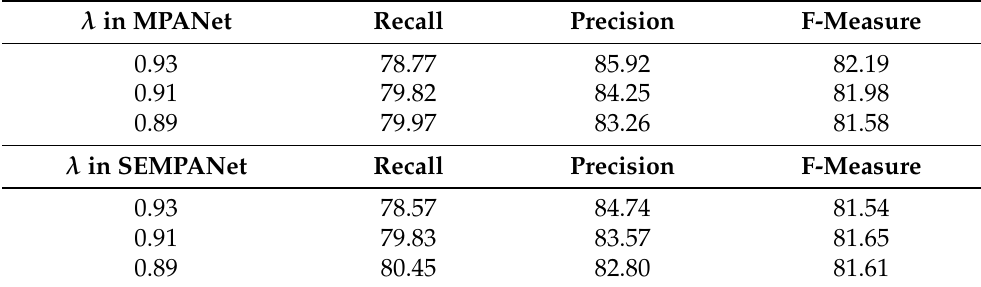
Table 3. The performance comparison of λ .